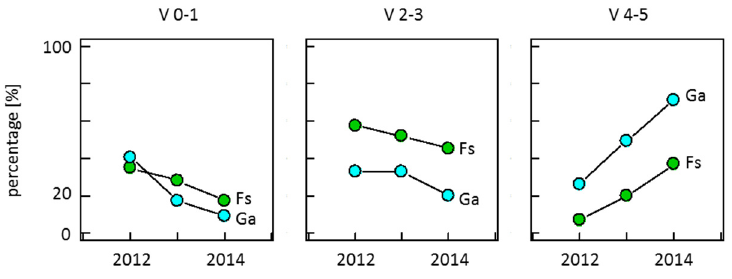
Figure 5. The development of ash vitality in Gaden (Ga) and Freising (Fs) from 2012 to 2014 is shown for trees belonging to the vitality classes 0–1, 2–3 and